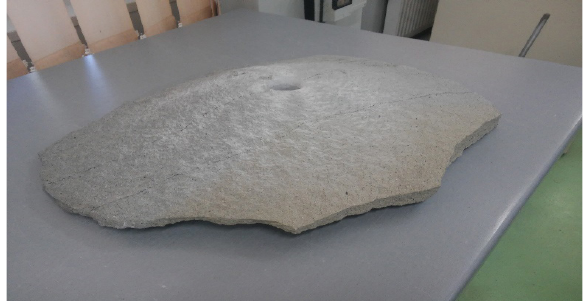
Figure 15: The shape of the actual pull-out sandstone sample.